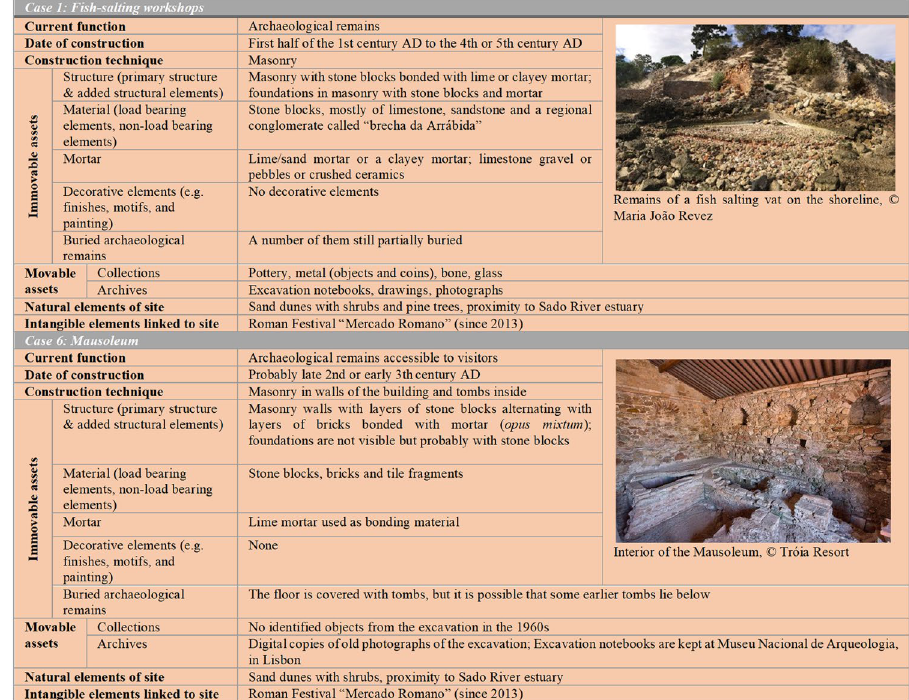
Fig. 2 Examples of identifica- tion records for heritage cases in Tróia. Photos reprinted with